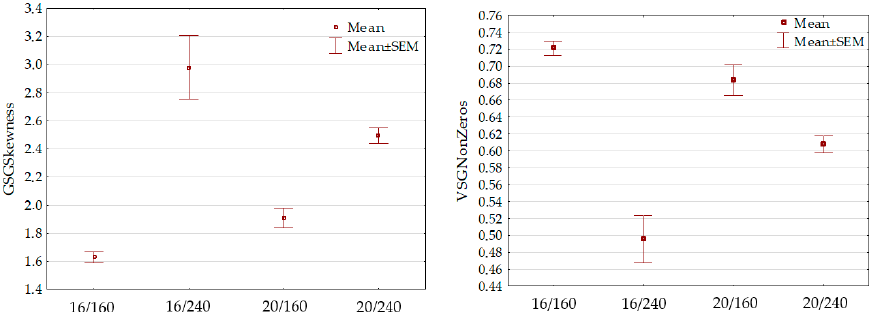
Figure 6. The values of selected image textures of the cv. ‘Casual’ lettuce leaves; SEM—standard error of the mean.